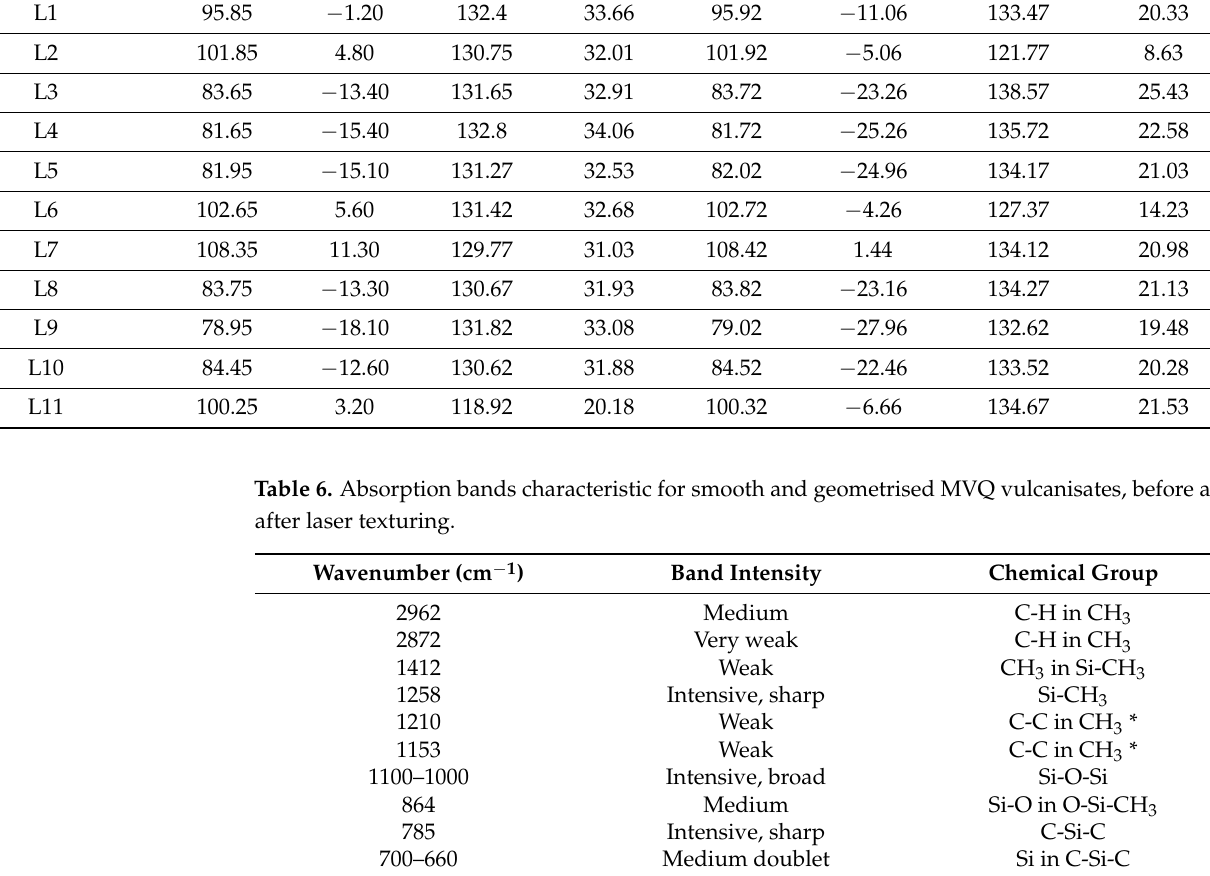
cation. The text continues here (Figure 2 and Table 2). Table 5. Results of contact angle measurements after laser texturing for chemically non-modified samples and samples after C1 modification.